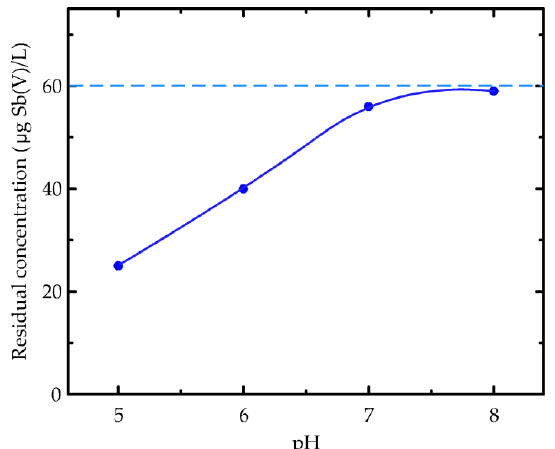
Figure 3. Influence of water pH on Sb(V) removal (experimental conditions: initial antimony concentration C o = 60 μg Sb(V)/L, Fe(III) dose 2.5 mg/L, T = 22 ± 1 °C ).